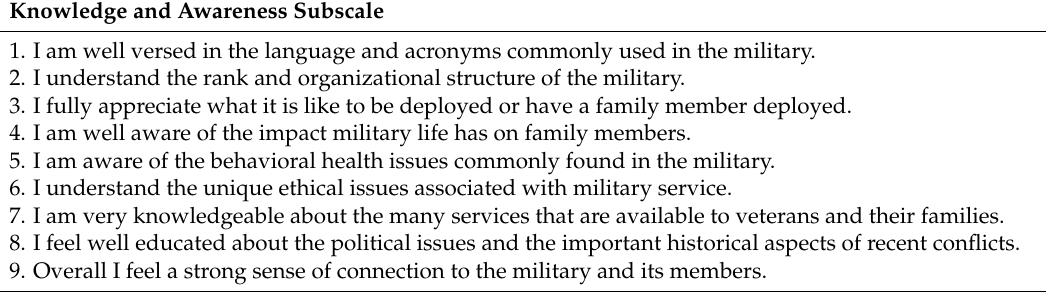
Table 2. MCCP Assessment Scale Survey